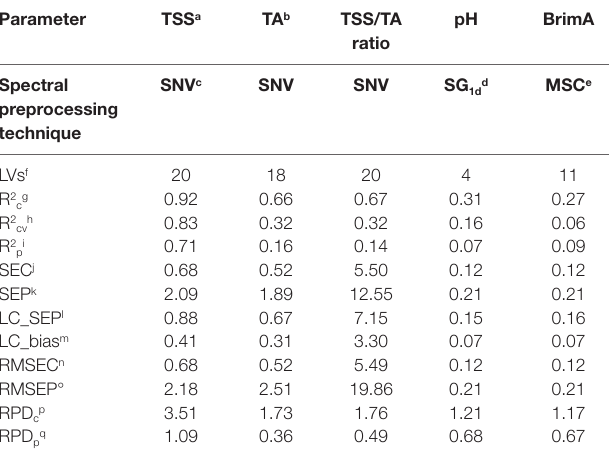
TABle 5 | Performance of Partial Least Squares (PLS) models for table grape quality parameters using 2016 data as the training set (n = 267) and 2017 as the testing set (n = 71). Also shown is the preprocessing techniques that gave the best model. Parameter